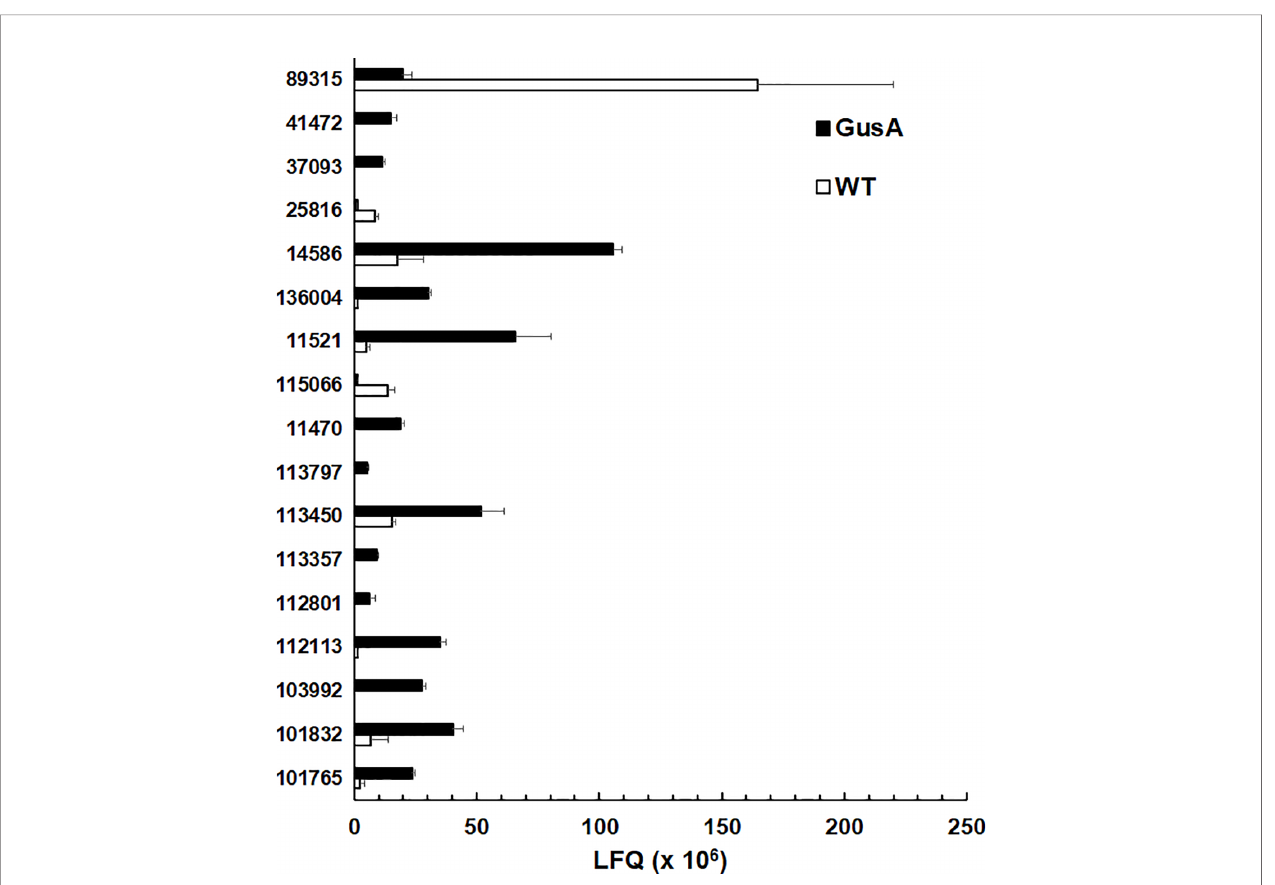
FIGURE 4 | Quantitative assessments of differential surface antigens. Untransfected G. lamblia WBC6 trophozoites (WT; white bars) and E. coli glucuronidase A-transfected trophozoites (GusA; black bars) were subjected to MS shotgun analysis as described in Materials and Methods section. For all proteins, mean values ± one standard deviation for LFQ intensities (x10 6 ) in three biological replicates are shown. The proteins are termed by their respective accession numbers in the GiardiaDB. 25816 and 113416 are high cysteine membrane